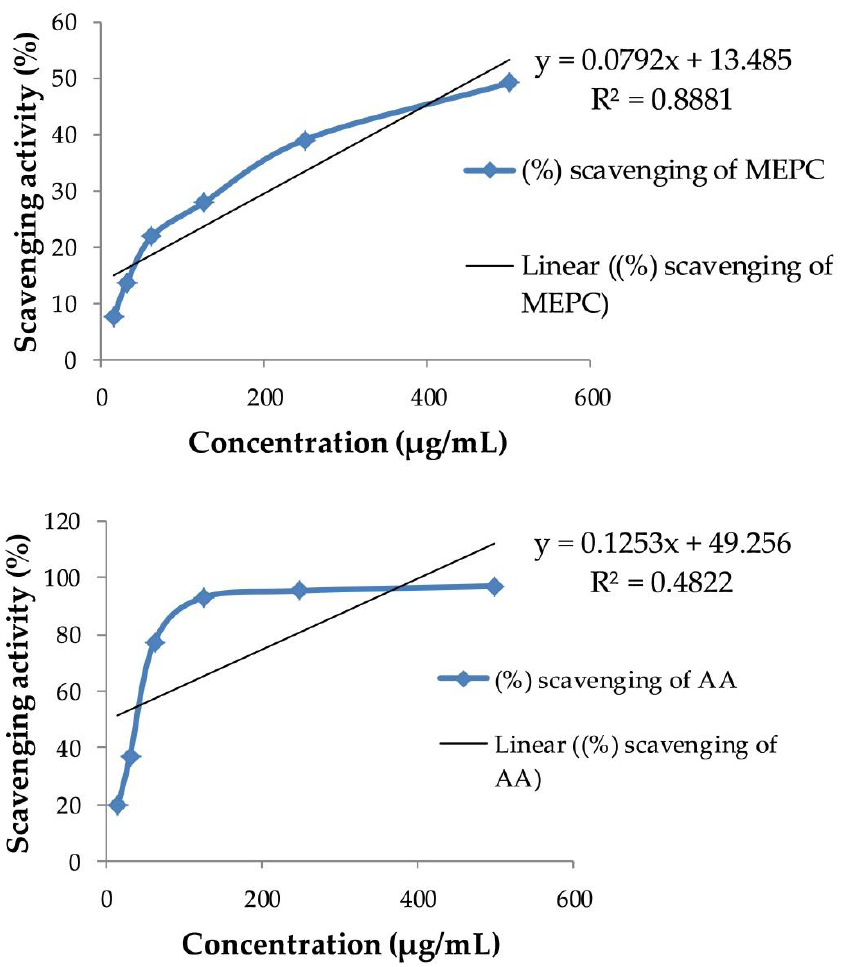
Figure 6. DPPH-scavenging activity of methanol extract of P. calocarpa (MEPC) and standard ascorbic acid (AA). Table 3. Antioxidant activity by total phenol content, total flavonoid content of methanol extract of P. calocarpa leaves with IC 50